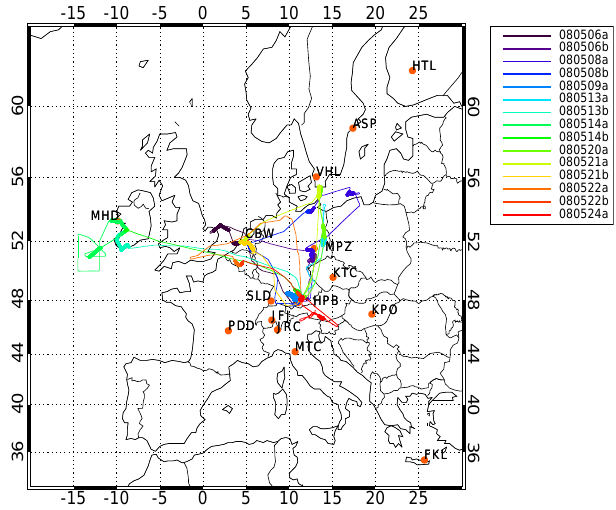
Fig. 1. Map of flight tracks performed by the DLR Falcon 20 re- search aircraft during the EUCAARI-LONGREX field campaign in May 2008. Sections of the DLR Falcon flight tracks that are at or below 2km are shown in bold. Orange dots mark the loca- tions of the European Supersites for Atmospheric Aerosol Research (EUSAAR) and the German Ultrafine Aerosol Network (GUAN) ground sites with aerosol number size distribution measurements for May 2008 (site acronyms are listed in Table